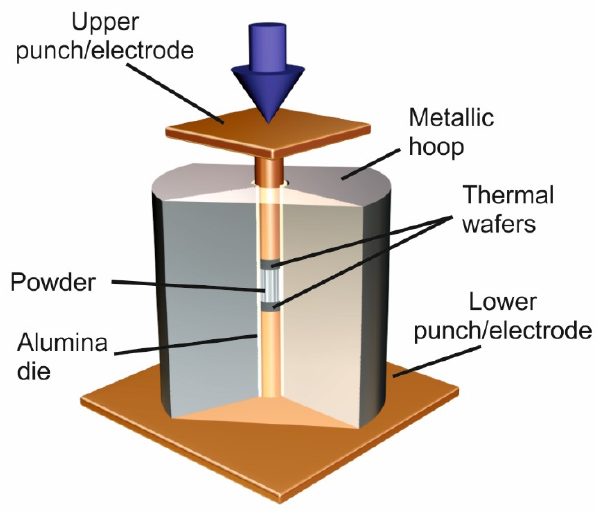
Figure 1. Sketch of punches and die used in MF ‐ ERS experiences.